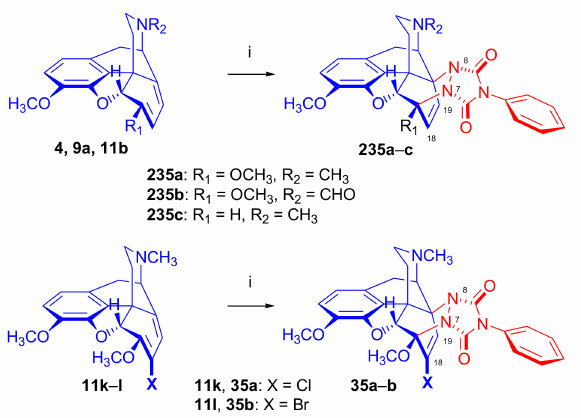
Figure 65. Reaction of 4-phenyl-4 H -1,2,4-triazoline-3,5-dione with various morphinan-6,8-dienes. Reagents and conditions : (i): PTAD, acetone, room temperature, 20–90 min.